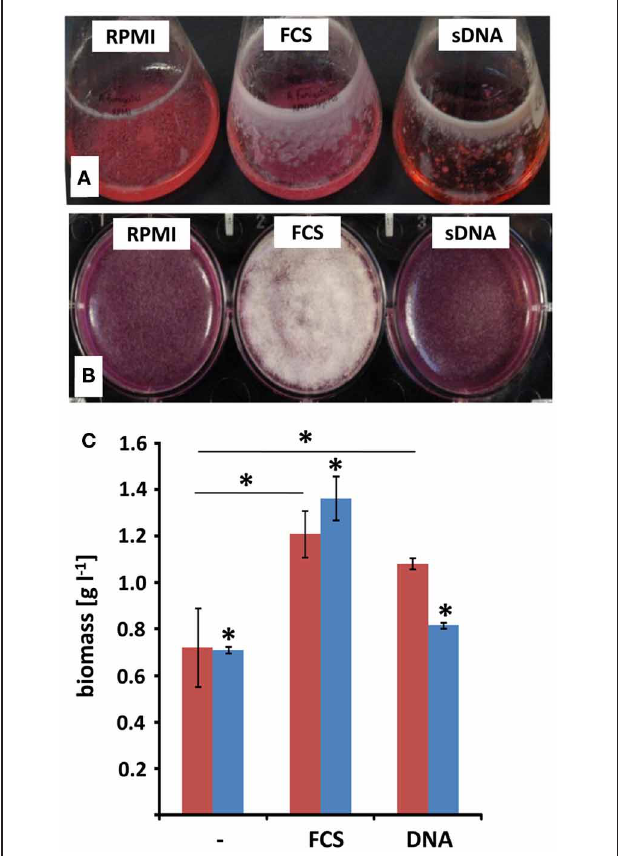
FIGURE 1 | Surface adhesion and biofilm formation with extrinsic DNA. A. fumigatus conidia were grown either in RPMI without additives (RPMI), with addition of 10% [v/v] fetal calf serum (FCS) or with 1mg ml − 1 sheared herring sperm DNA (sDNA) in submerged, shaken culture (A) or in static biofilm inducing conditions (B) . Growth was monitored after 48h and expressed as total biomass formation during shaking (blue) and static (red) culture conditions (C) . Displayed values represent the means and SDs of three independent experiments and asterisks indicate p < 0 . 05 in Student’s t